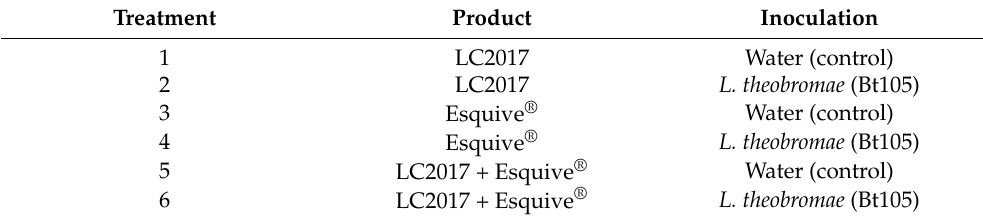
Table 1. Treatments tested on cultivars Cabernet Sauvignon and Touriga Nacional. Treatment Product Inoculation 1